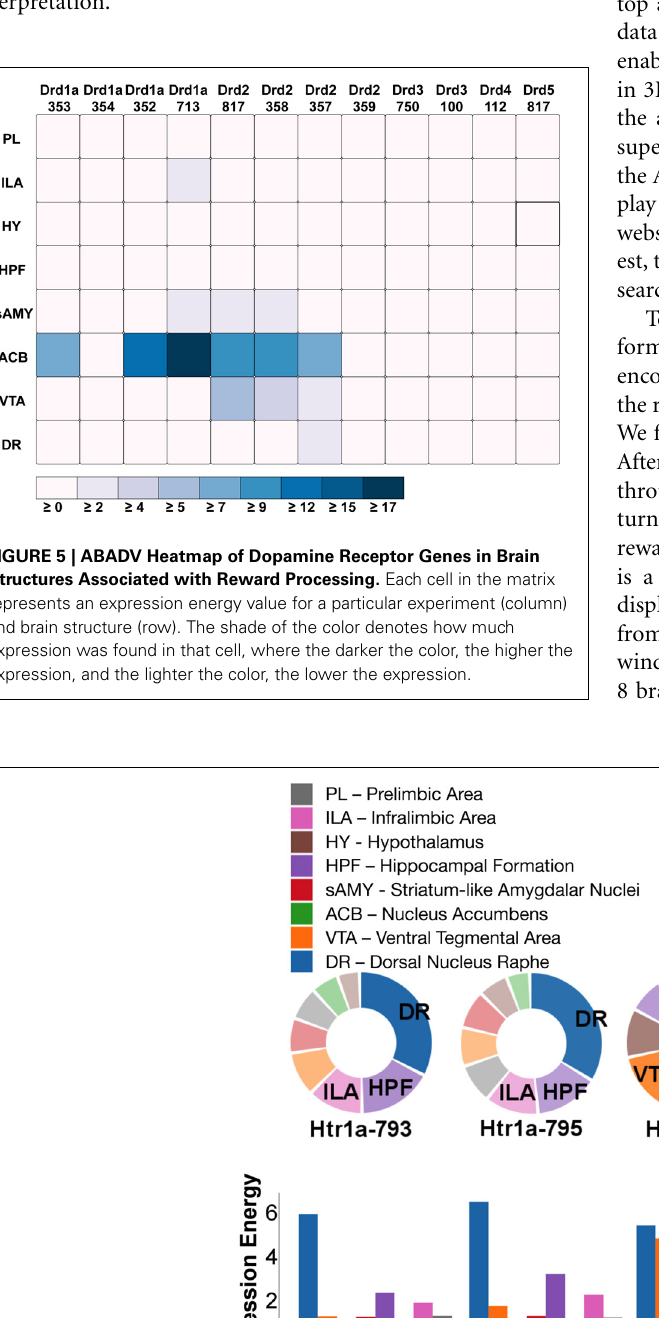
denotes the amount of expression energy relative to other brain structure within the same gene. (Bottom) Each group of bars represents a different gene expression experiment, while each bar within a group represents a different brain structure. Height of bar denotes the amount of expression energy. Default color generated D3 was used in this